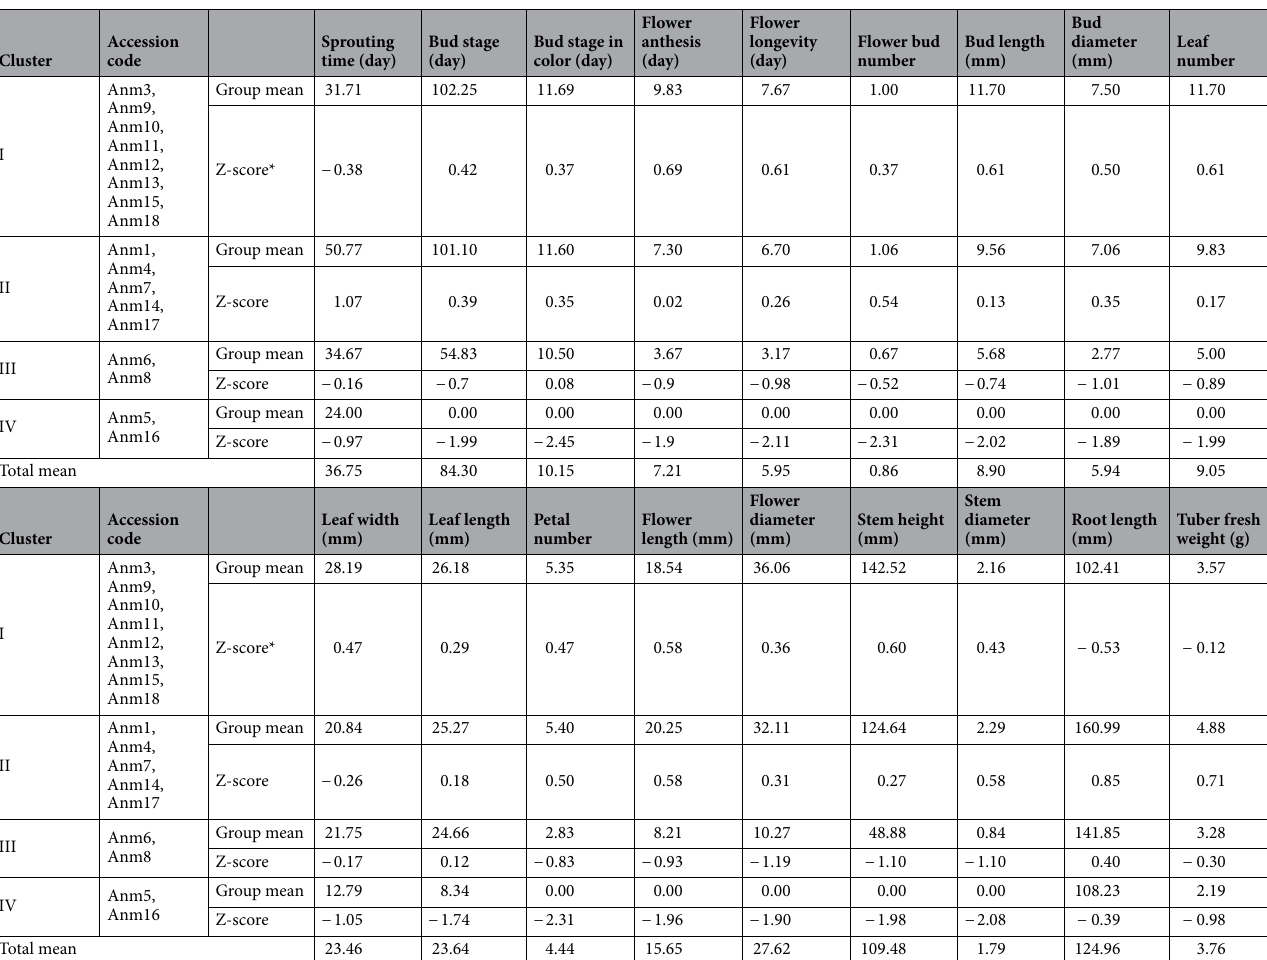
Table 4. Composition of the groups and the distribution of the Anemone accessions in each group based on cluster analysis under non-chilling pre-treatment. *: Z-score was calculated as the difference between the mean of the trait (for each group) and the total mean, divided by the total standard deviation (SD). The highest positive Z-scores are associated with the relative highest value of the variable among the groups. Since the decrease in the value of phenological traits (except for flower longevity on plant) is a desirable feature, the groups with further negative Z-scores were considered to be more superior. Conversely, since the increase in the value of morphological traits is a desirable feature, the groups with further positive Z-scores were considered to be